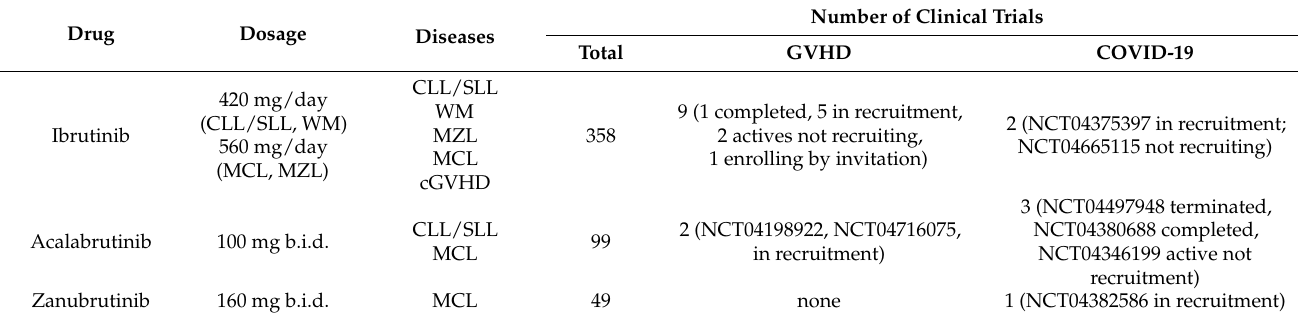
Table 1. Dosage, clinical trials and treated diseases of approved